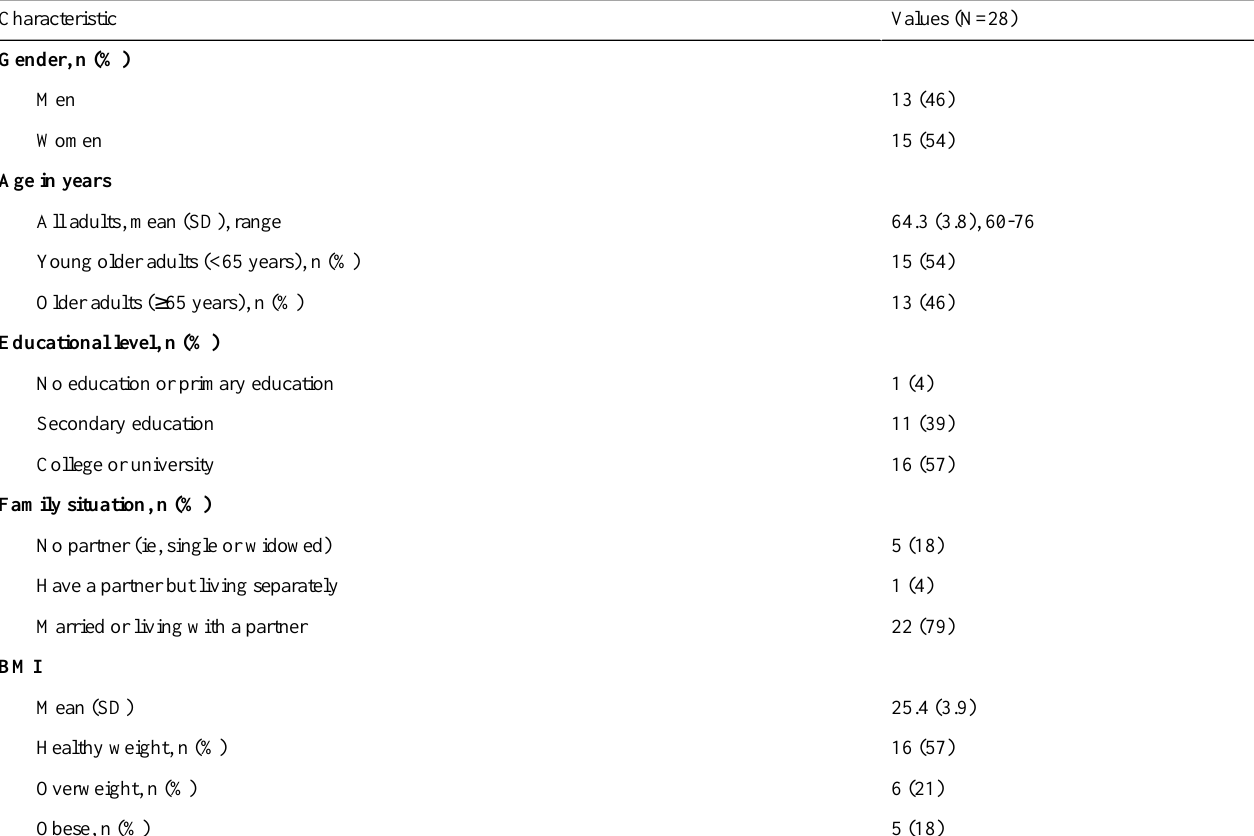
Table 1. Baseline characteristics of the participants.